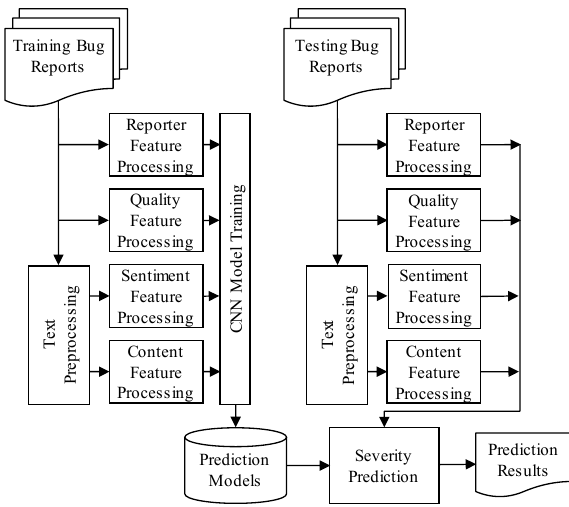
Figure 2. Prediction process of MASP.